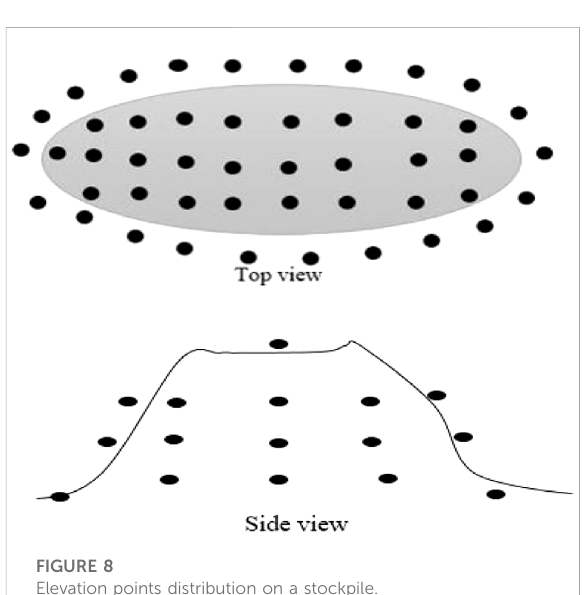
FIGURE 9 Target marks on a GCP and checkpoint.